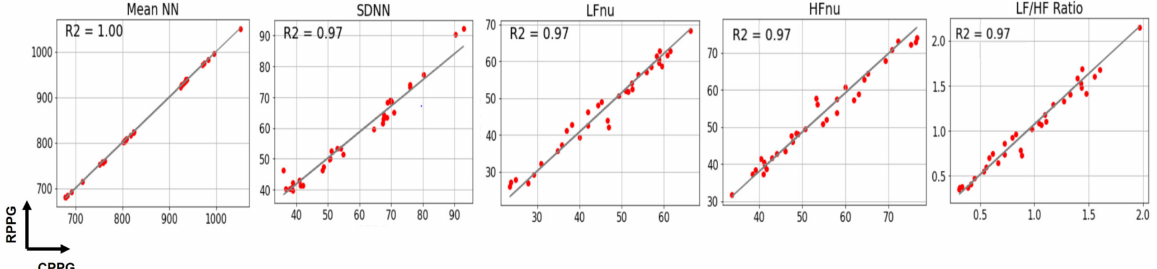
Figure 9. PRV indicator plots and correlation coefficients of CPPG and